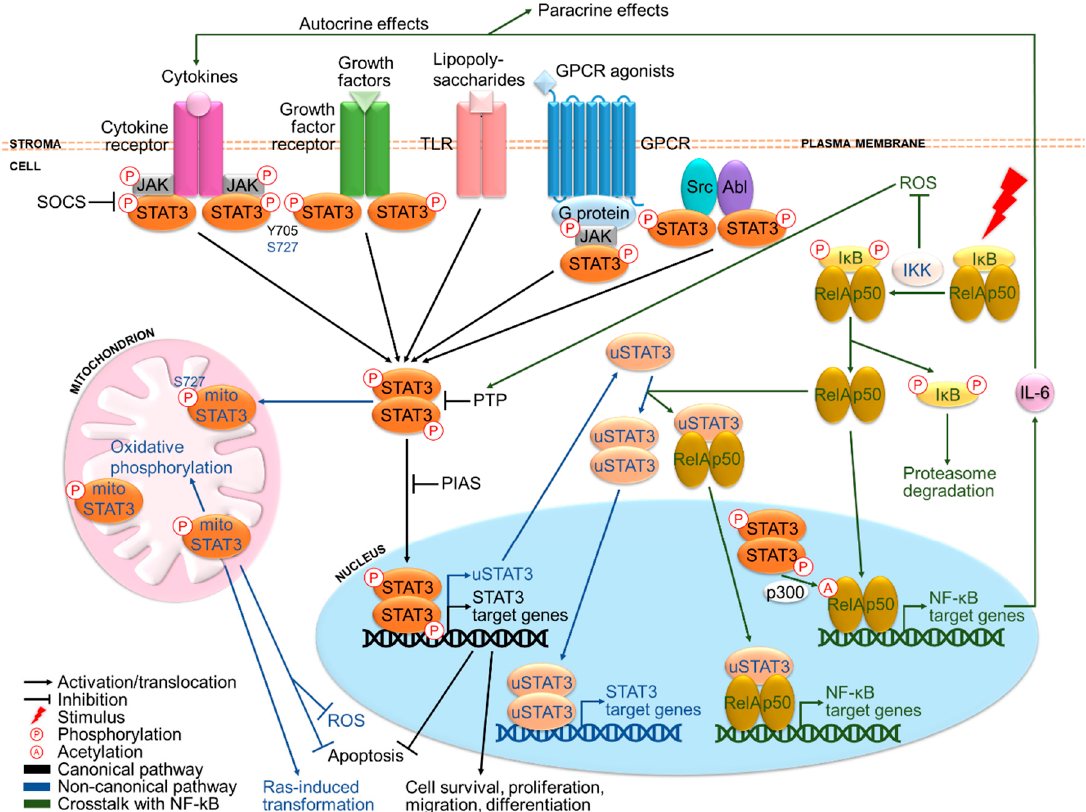
Figure 1. The STAT3 signaling pathway and its crosstalk with NF-kB. STAT3 is activated primarily by cytokines and growth factors, in addition to other signaling molecules. Canonically, ligand binding to receptors triggers phosphorylation of tyrosine kinases and subsequently STAT3 at Y705, followed by STAT3 dimerization and translocation to the nucleus where it drives transcription of target genes involved in cell survival and proliferation. Non-canonically, STAT3 can also be phosphorylated at S727, translocate to the mitochondrion, as well as autoregulate its own transcription to produce u-STAT3. Under normal conditions, STAT3 activation is under tight negative regulation by SOCS, PTP and PIAS members. Remarkably, STAT3 is involved in extensive crosstalk with the inflammatory NF-kB pathway. Activated NF-kB has been reported to either activate or inhibit STAT3 signaling, respectively by producing various cytokines including the major STAT3-inducing cytokine IL-6 and preventing reactive oxygen species (ROS) accumulation responsible for oxidizing negative regulators of STAT3. In return, STAT3 may sustain NF-kB activation via p300-mediated acetylation. Moreover, u-STAT3 and u-NF-kB can work in concert to coregulate another set of genes.